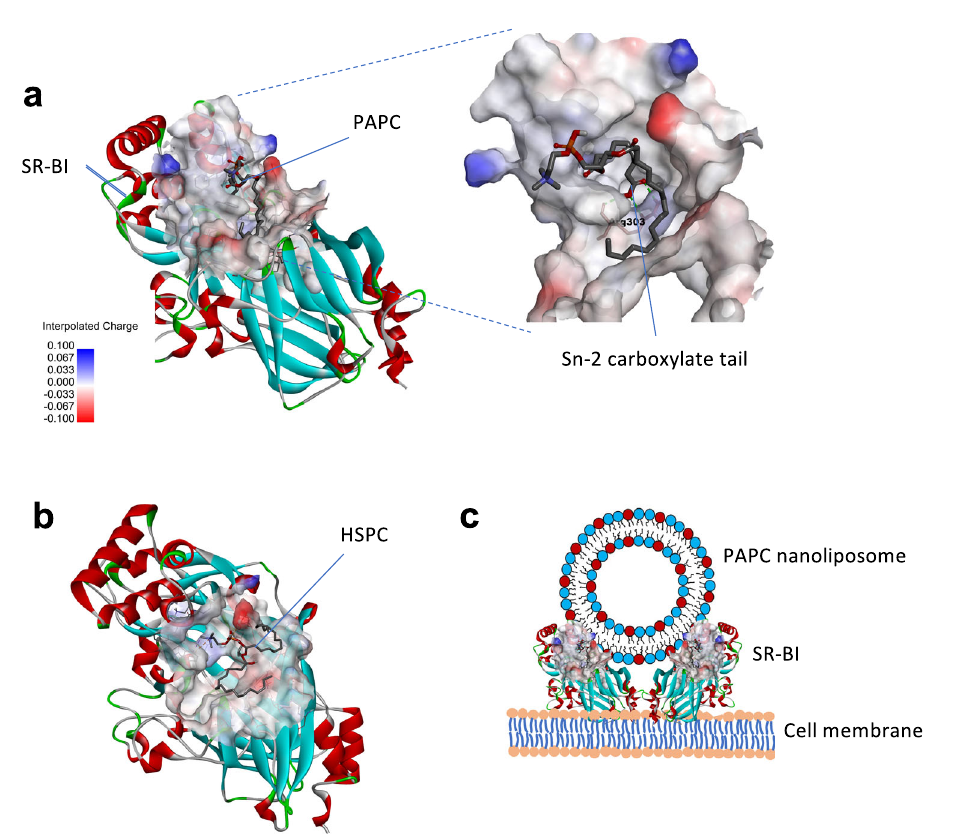
Fig. 4 | Molecular docking analysis for binding of PAPC and HSPC with SR-B1 receptor.a DockingimageshowingbindingofPAPCwithSR-B1structureobtained using Autodocksoftware. The SR-B1 structureshow cationicsites(light blue color) which forms a pocket for the interaction with PAPC. The carboxylated sn-2 tail